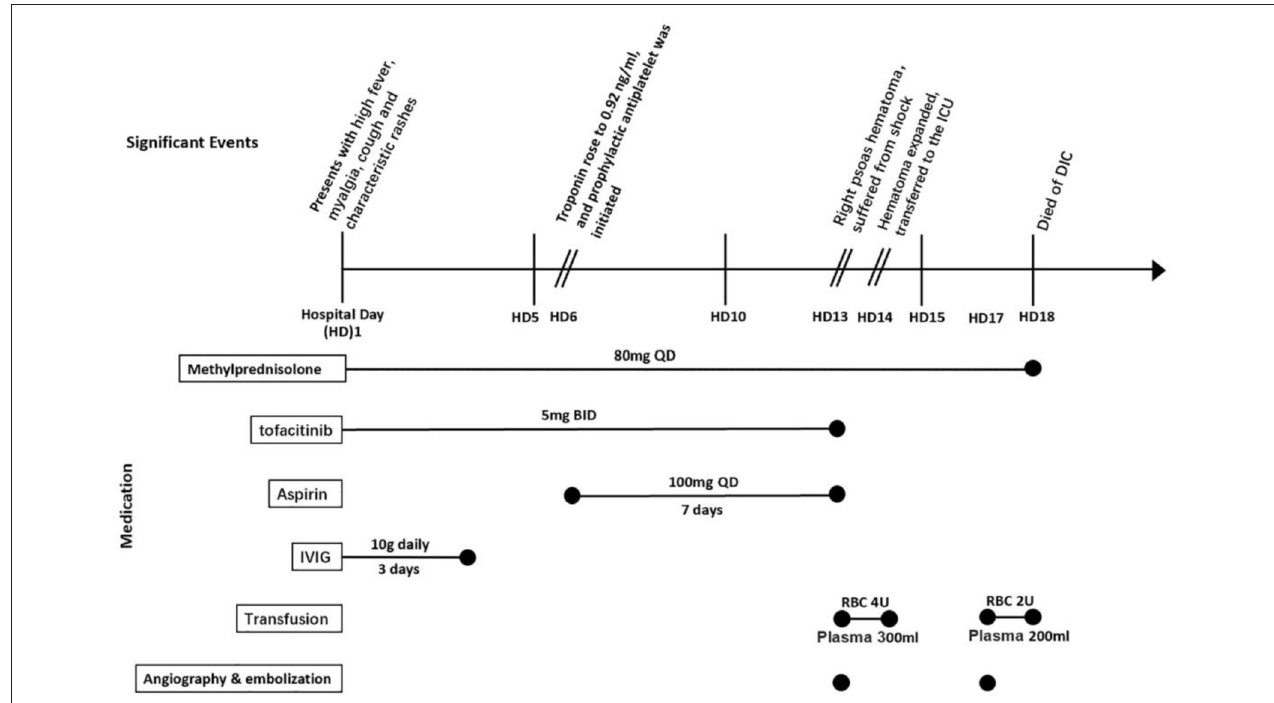
FIGURE 1 | Timeline of significant events and medication regimen for presented case 1 (listed as case no. 17). ICU, intensive care unit; DIC, disseminated intravascular coagulation; IVIG, intravenous